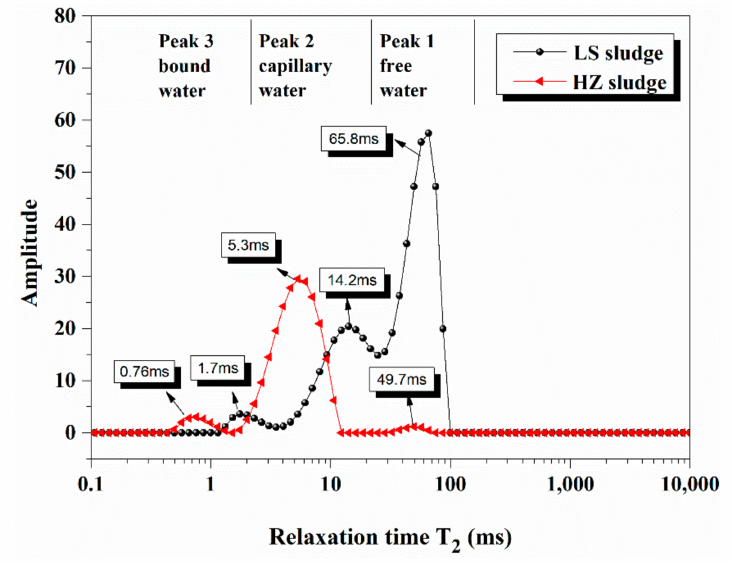
Figure 1. Relaxation time (T 2 ) distribution curves of Lishui sludge (LS) and Hangzhou sludge (HZ)